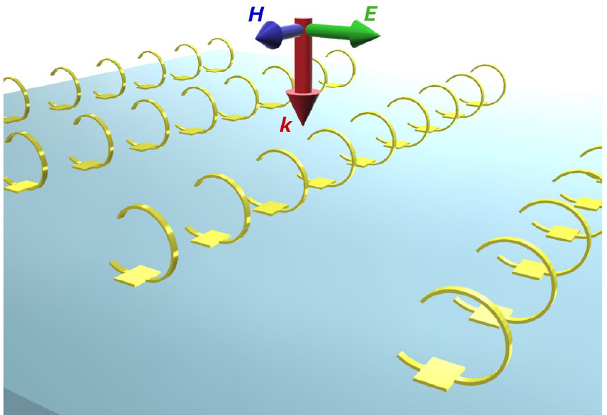
Figure 1. A schematic of 3D-SRRs with inversion symmetry along z- axis fabricated by using a metal-stress- driven self-folding method for non-bi-anisotropic response.